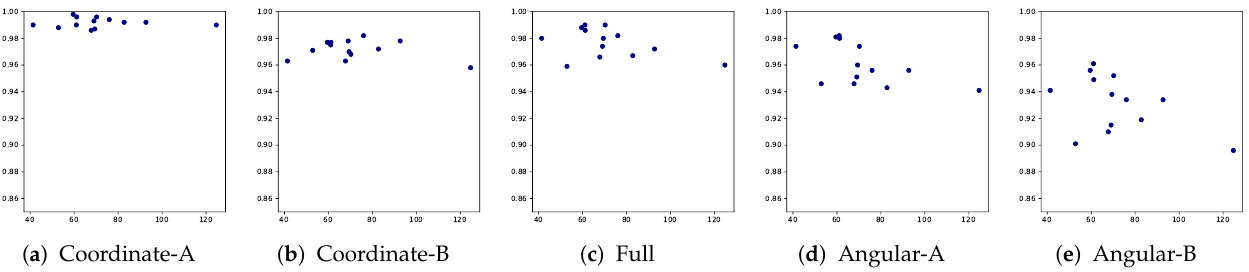
Figure 12. Average AUROC according to sequence length for each variable combination set by RNN (x-axis: sequence length, y-axis: